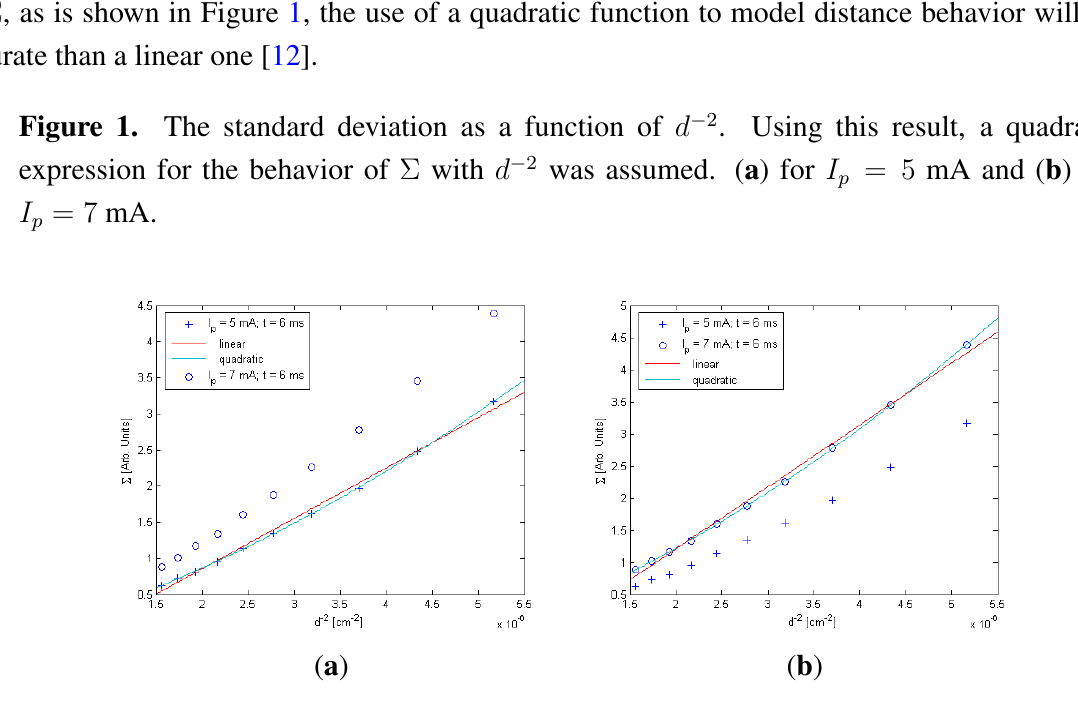
The standard deviation as a function of d − 2 . Using this result, a quadratic